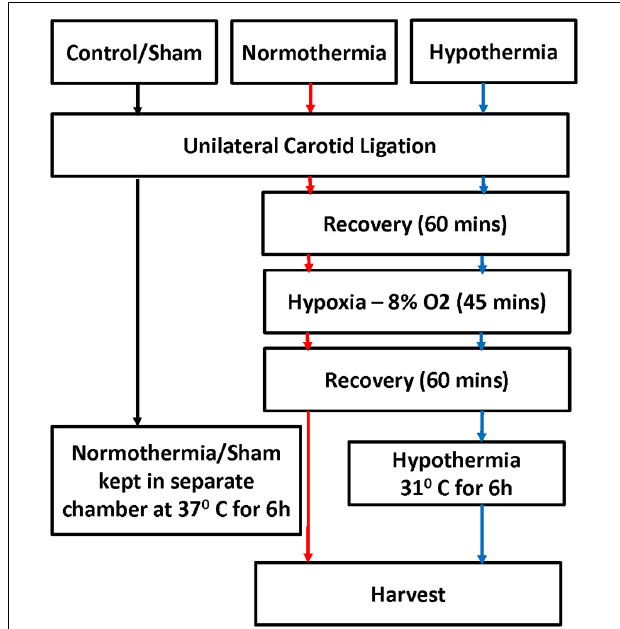
FIGURE 2 | Experimental protocol. Term equivalent rat pups at P10-12 were randomly assigned to three different treatment groups: no intervention/sham (control), normothermia (NT) and hypothermia (HT). Experimental animals underwent unilateral carotid ligation followed by exposure to hypoxia (8% O 2 /balanced nitrogen, Vannucci model) for 45 min. HT animals were placed in open jars in a temperature-controlled chamber to maintain a target rectal temperature of 31–32 ◦ C for 6 h, Control, NT, and HT animals were kept in a separate chamber at 37 ◦ C. After intervention, pups were placed back with the dam, and harvested at different time